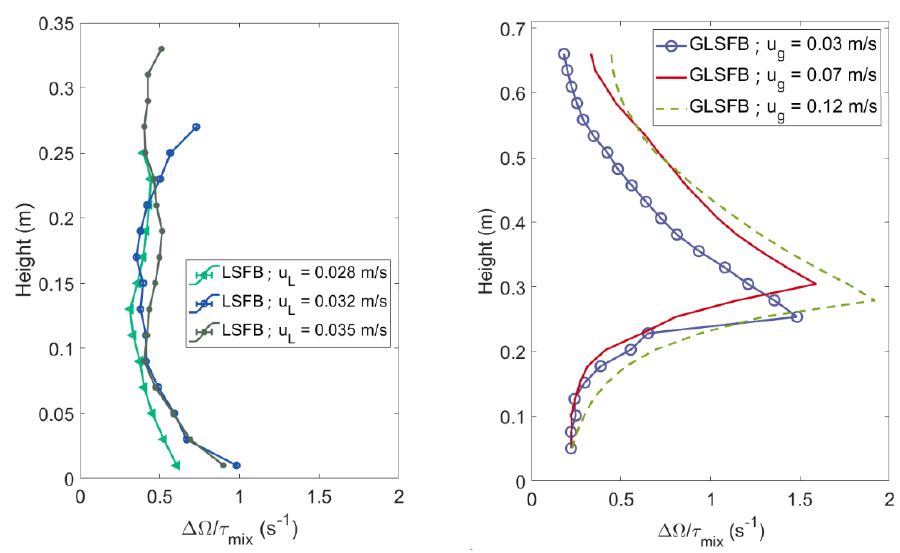
Figure 7 . Normalized Shannon entropy production depending on the column height for LSFB ( left ) and the GLSFB ( right ) systems under different stirring conditions.